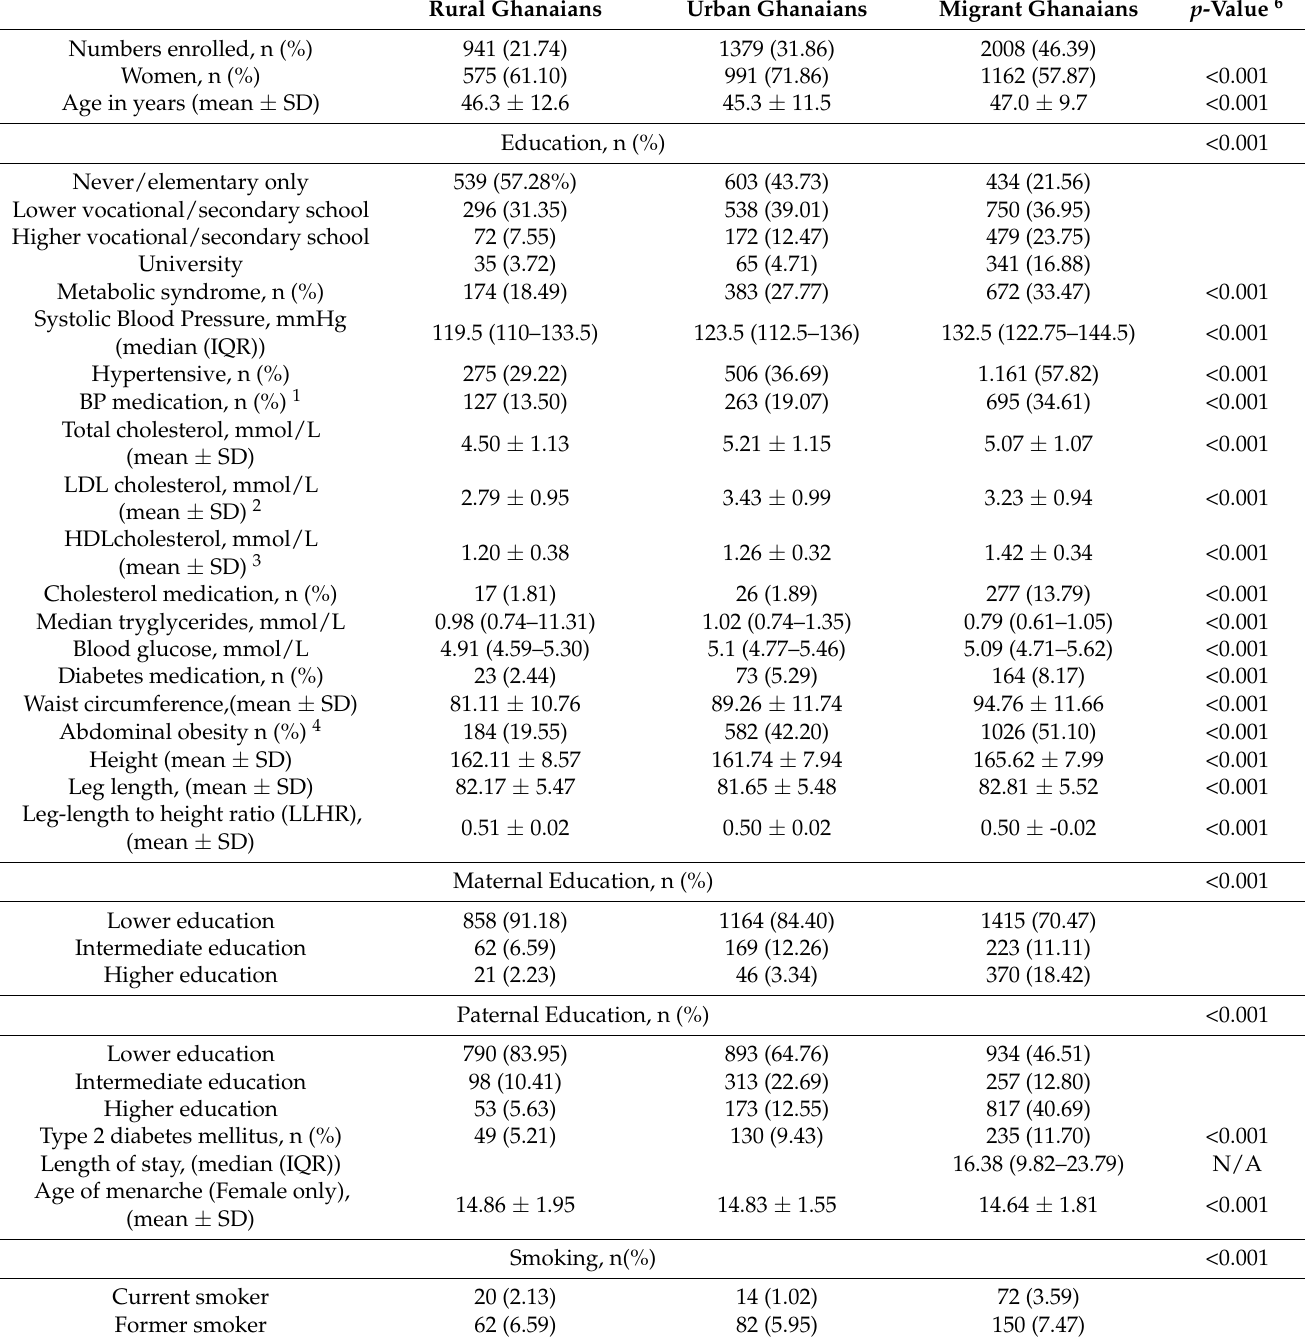
Table 2. Baseline characteristics of participants included in present analyses. Rural Ghanaians Urban